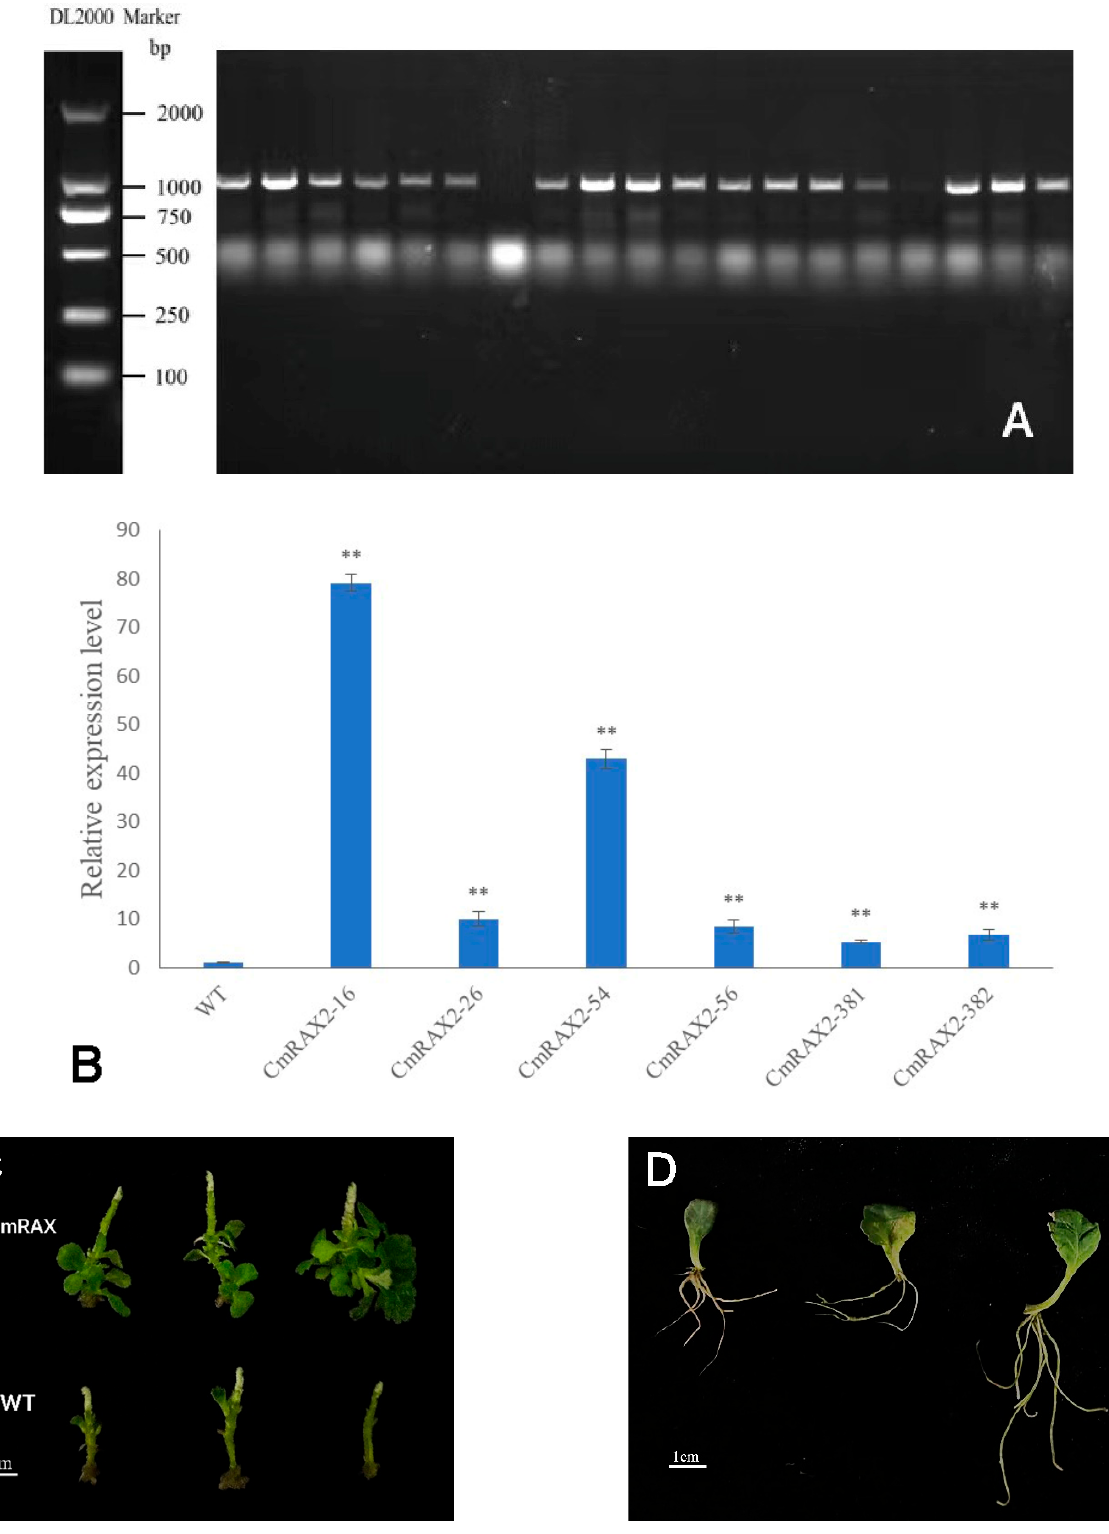
Figure 7. ( A ) PCR detection of kanamycin-resistant plants. ( B ) qRT-PCR of kanamycin-resistant plants. The lines are used to show standard errors. The ** means significantly higher than wild-type plants. ( C ) Transgenic chrysanthemum and wild-type plants 30d after transplantation. ( D ) Leaf rooting.